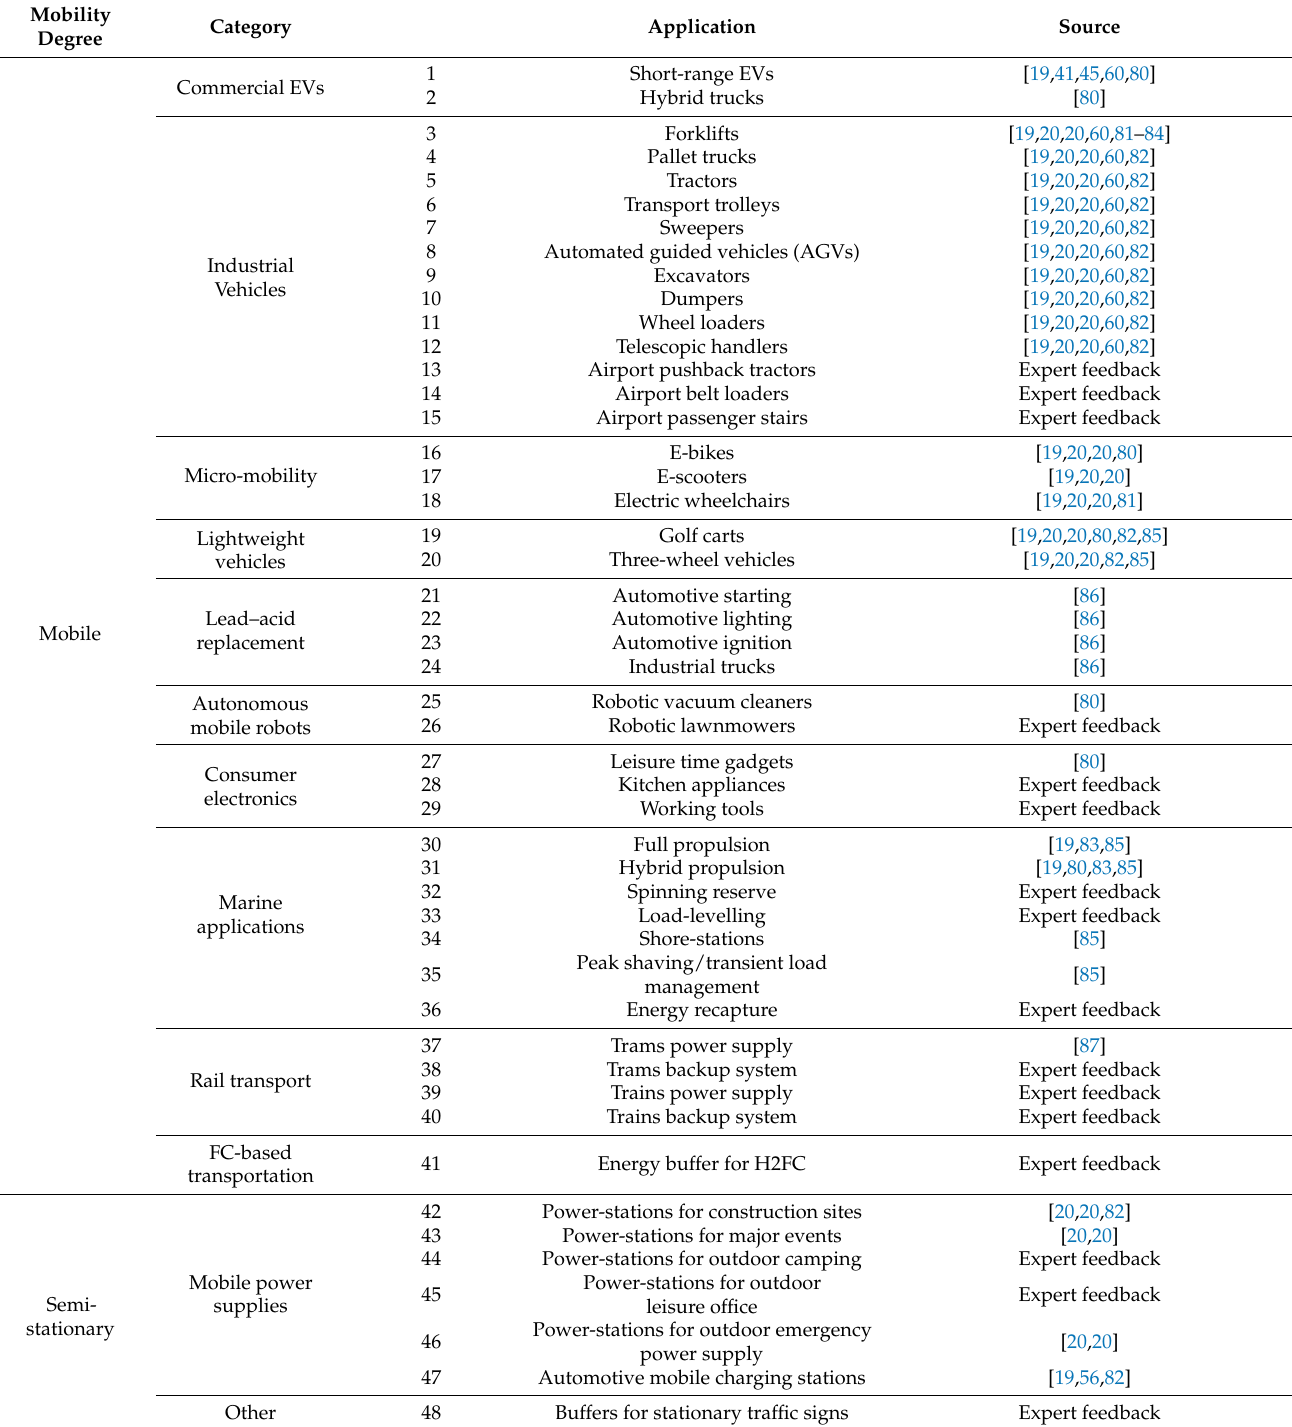
Table 1. Potential second-life